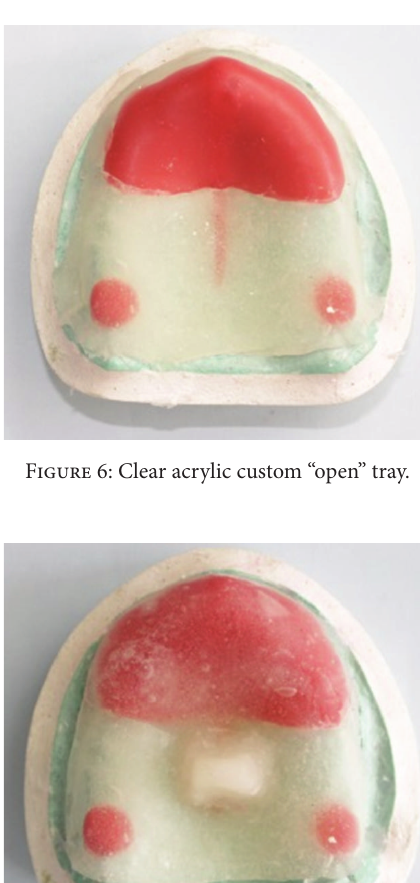
Figure 4: Relief wax placed over the mandibular arch.